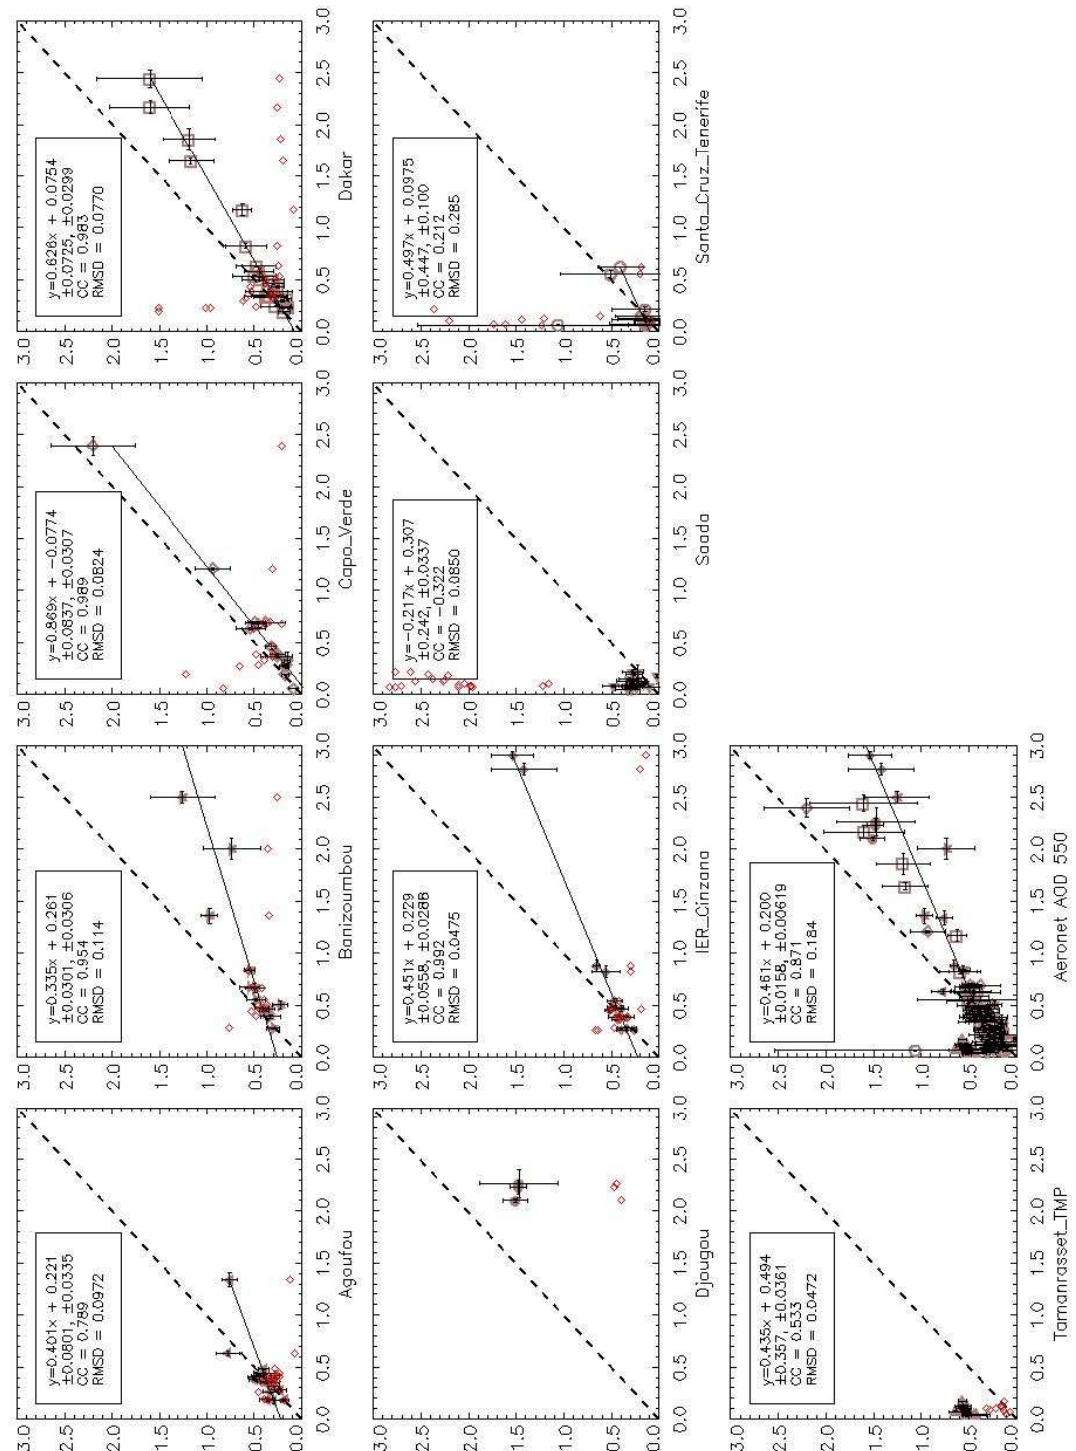
Fig. 4. Example of a scatter plot between AERONET data (x) and satellite (y) for SEVIRI-ORAC. The black/brown symbols are satellite datasets (y) vs. AERONET AOD (x). Different locations are represented by different symbols, as with Fig. 3. The red stars represent two times the AERONET ˚Angstr¨om coefficient (between 440 and 870nm). The final plots show all the coincidences. In every scatter plot with more than four coincidences, there are captions indicating the best linear fit (angular coefficients, y intercept and associated errors), the correlation coefficient (CC) and the root-mean-square differences (RMSD).